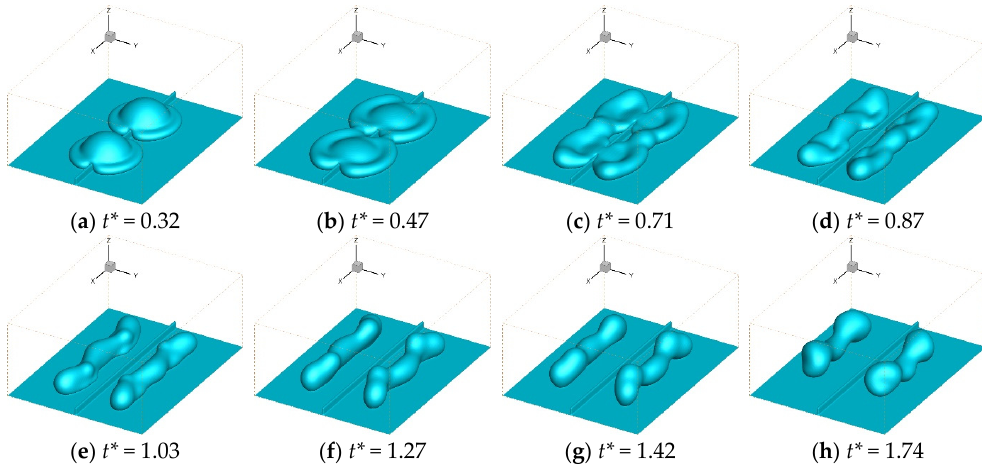
Figure 7. Snapshots of two droplets simultaneously impacting the S3 surface at L x * = 1.67. The morphologies at different moments are illustrated in ( a – h ).